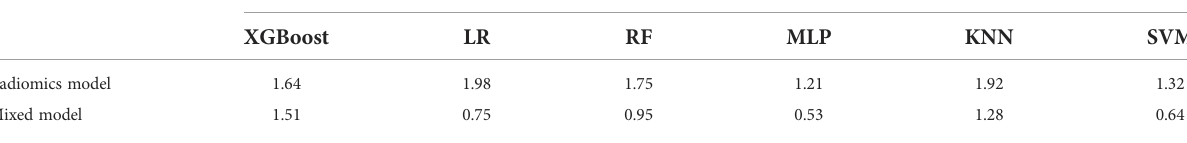
TABLE 4 The RSD of classi fi ers for radiomics and mixed model in the training cohort.